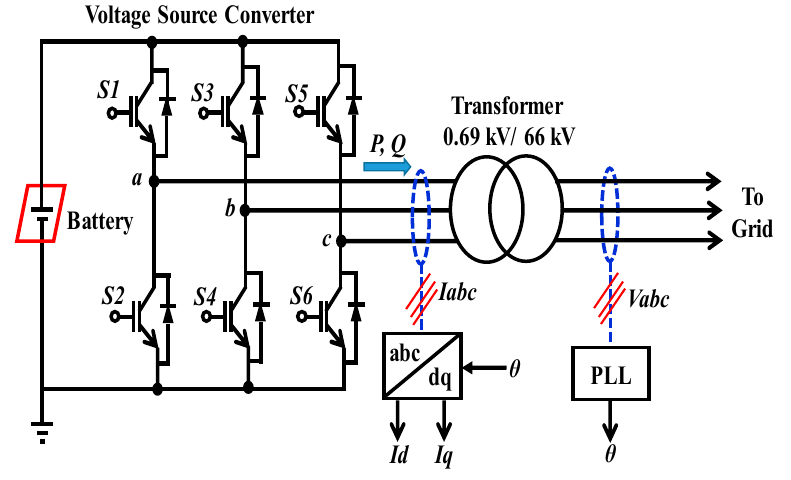
Figure 8. Proposed battery storage system (BSS).